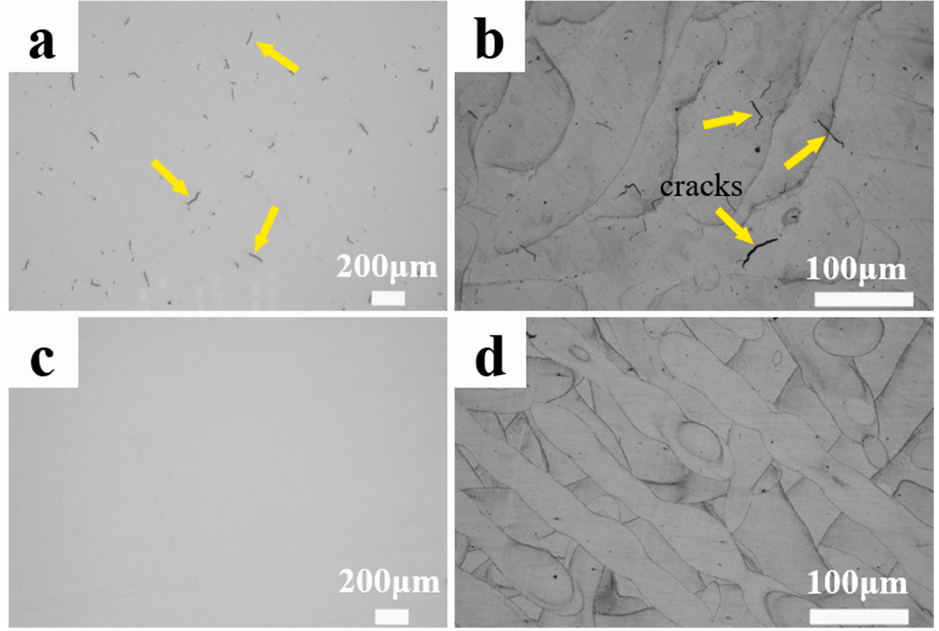
Figure 11. OM images of LBPBF manufactured specimens, ( a , b ) undoped specimen; ( c , d ) Y 2 O 3 - doped specimen [73].